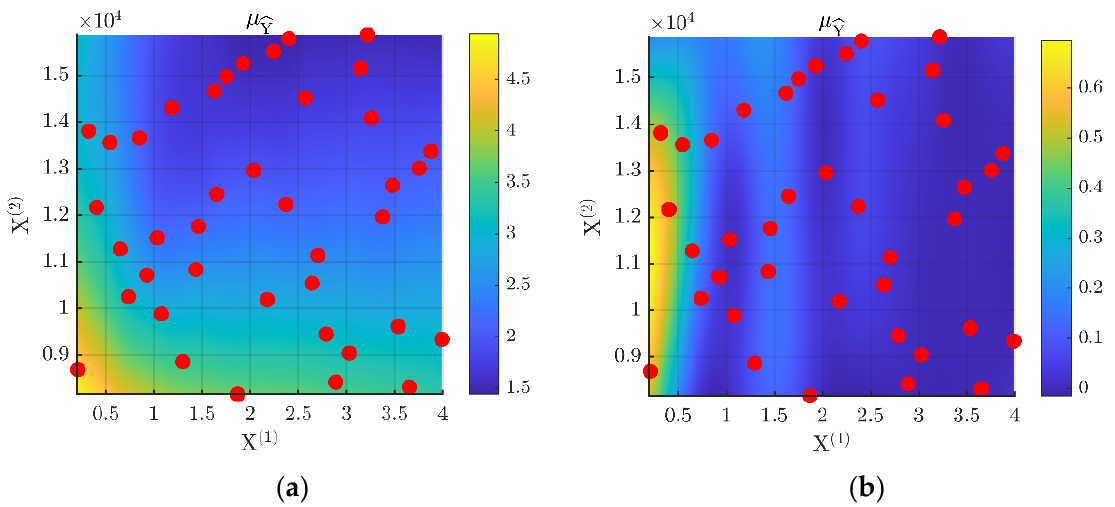
: ( a ) Mean and ( b ) Oscil- Y